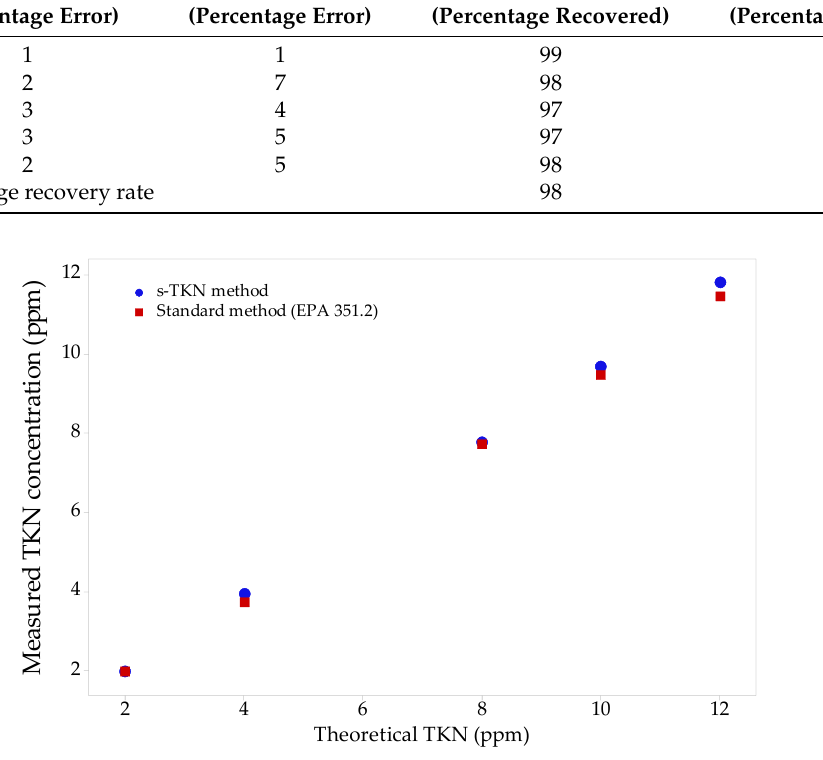
Figure 1. TKN concentrations in Nic-PTSA analyzed using the s-TKN TM method and standard method. Table 1. Error rate and recovery rate of nitrogen using the simplified TKN method and the standard method ( EPA 351.2) using the nicotinic acid-PTSA standard.